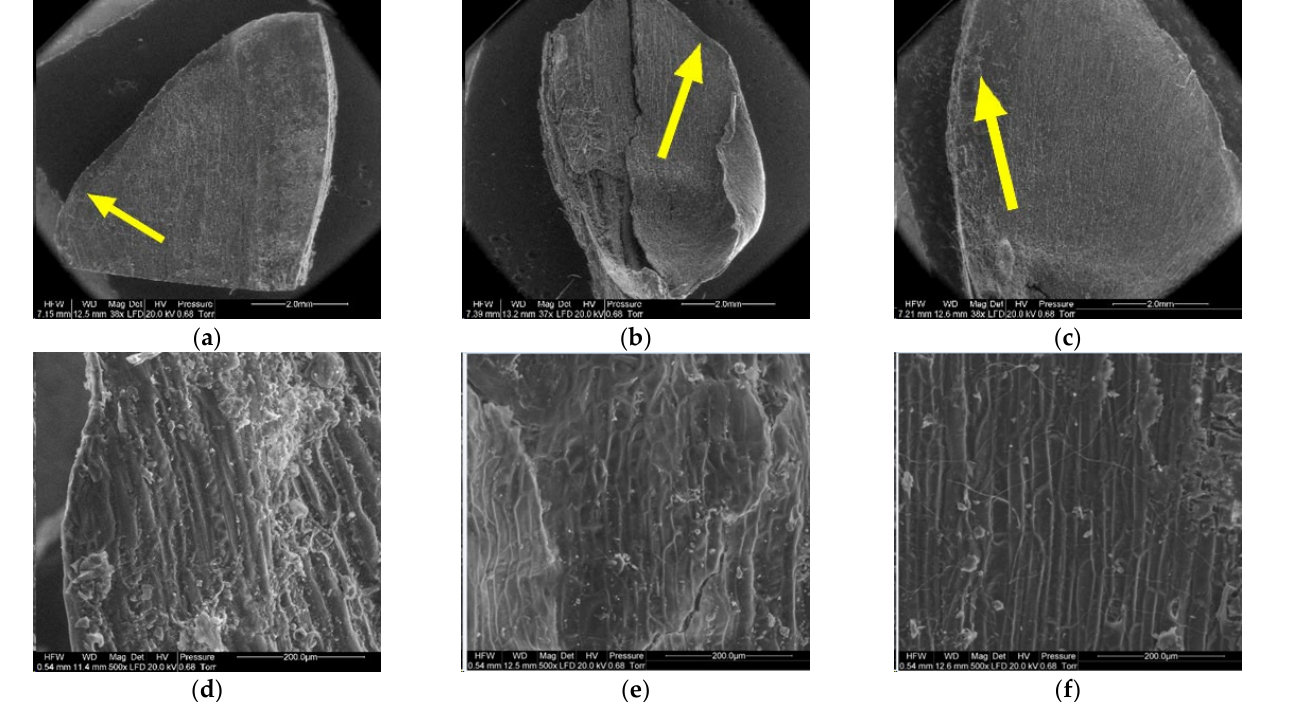
Figure 8. Inner side of larch scale. Scale margin outside of the wing area: ( a ) MC = 20%, zoom 50×; ( b ) MC = 10%, zoom 50×; ( c ) MC = 5%, zoom 50×; ( d ) MC = 20%, zoom 500×; ( e ) MC = 10%, zoom 500×; and ( f ) MC = 5%, zoom 500×.